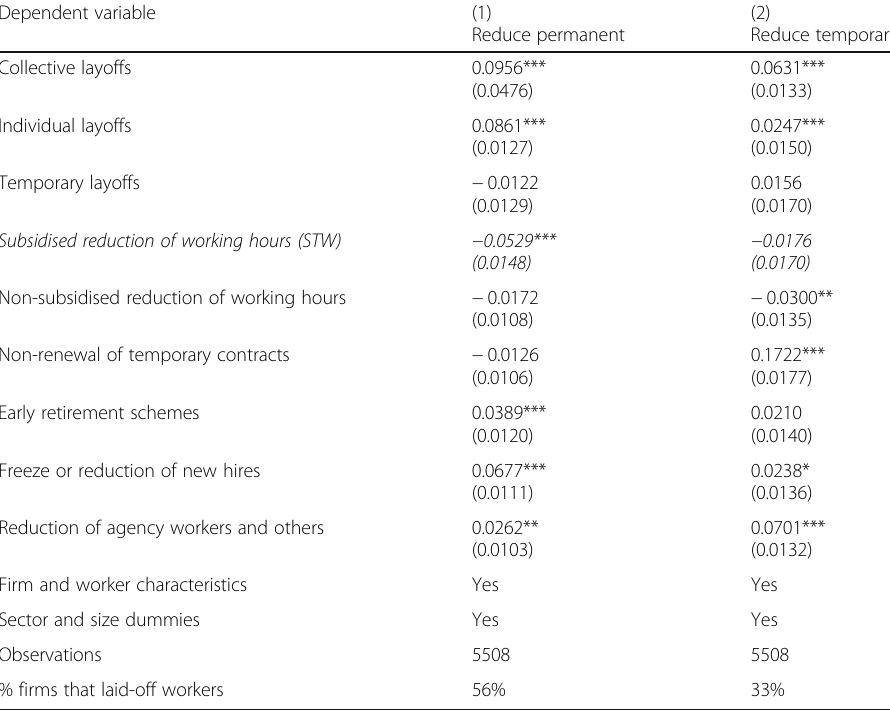
Table 7 The effect of STW usage on the propensity to lay off workers Dependent